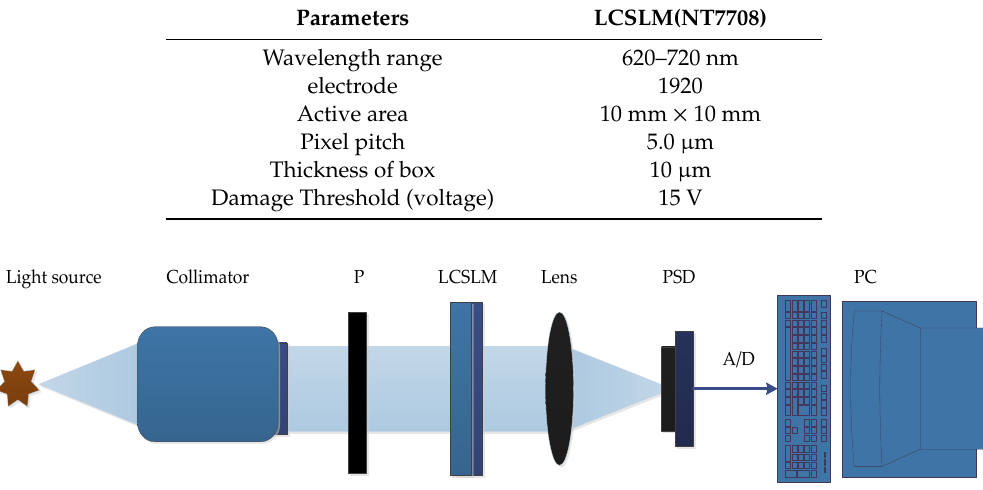
Table 1. Parameters of Nematic liquid crystal. LCSLM: Liquid crystal spatial light modulator.